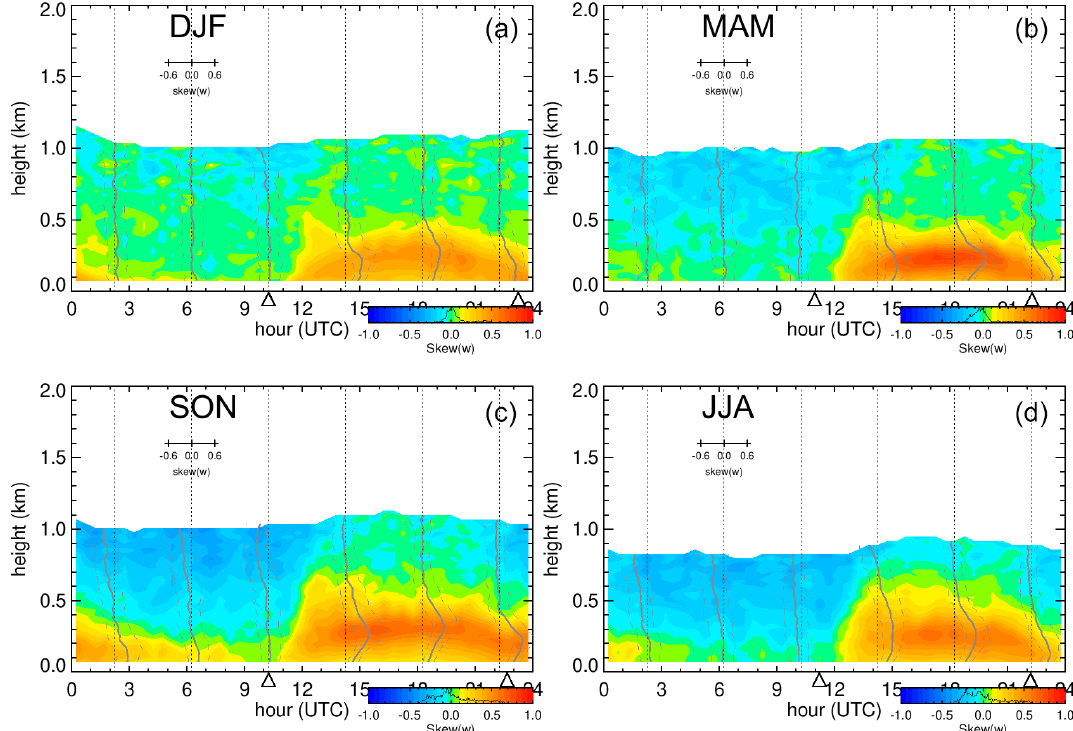
Figure 12. Time–height sections of vertical velocity skewness during the four seasons (color shading). Gray lines are the median profiles (solid) and interquartile range (dashed) at the times indicated by the dotted vertical lines. Time is given in hours UTC such that night appears on the left-hand side and daytime on the right-hand side of each plot. Triangles at the abscissa indicate average times of sunrise and sunset, respectively.